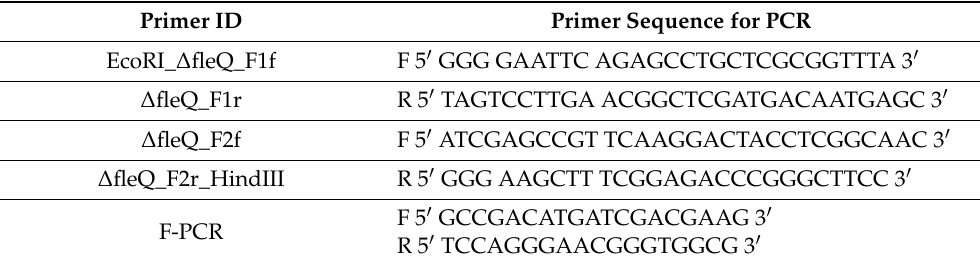
Table 1. List of primers used in this